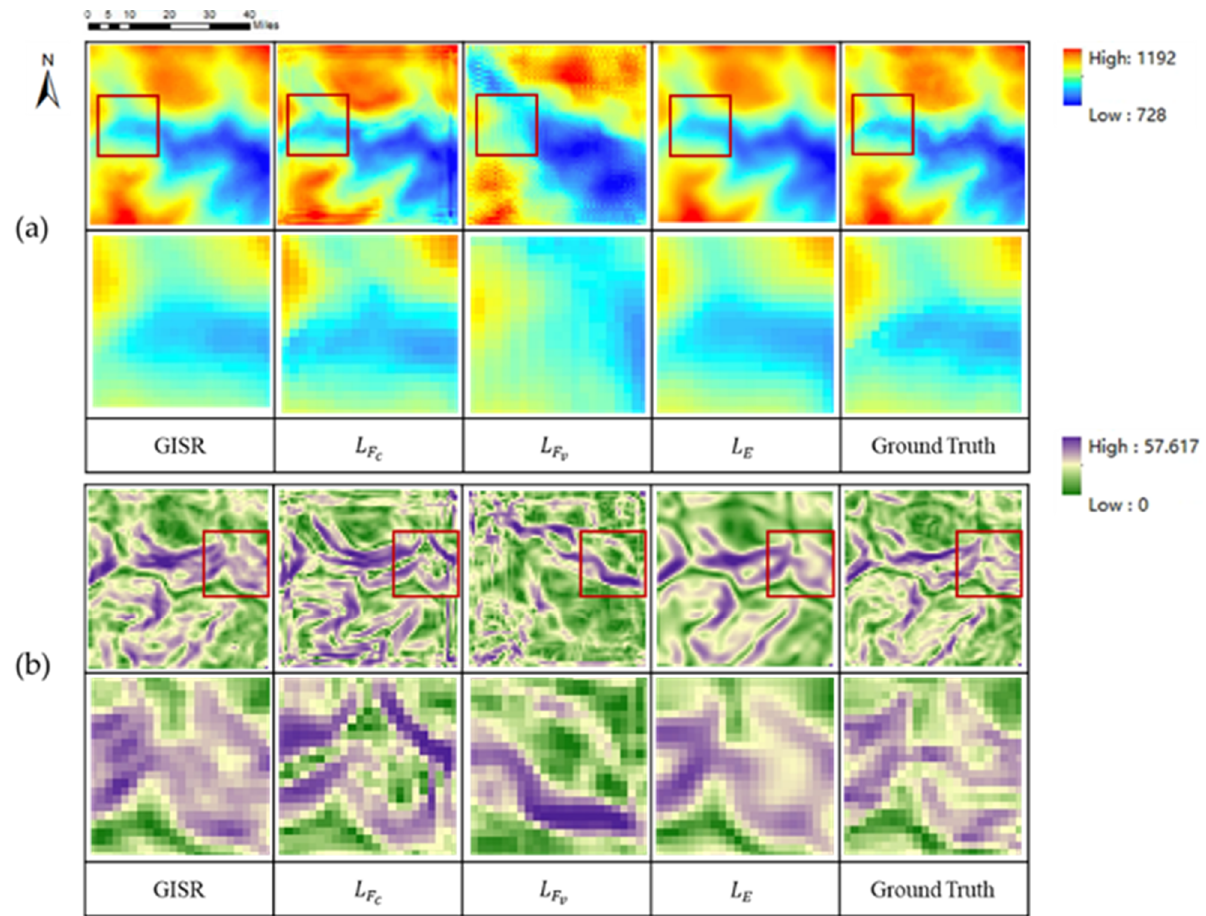
Figure 15. Results of different loss schemes: ( a ) is the DEM SR result, and ( b ) is the DEM SR slope ( The details in the red box are in the next row).